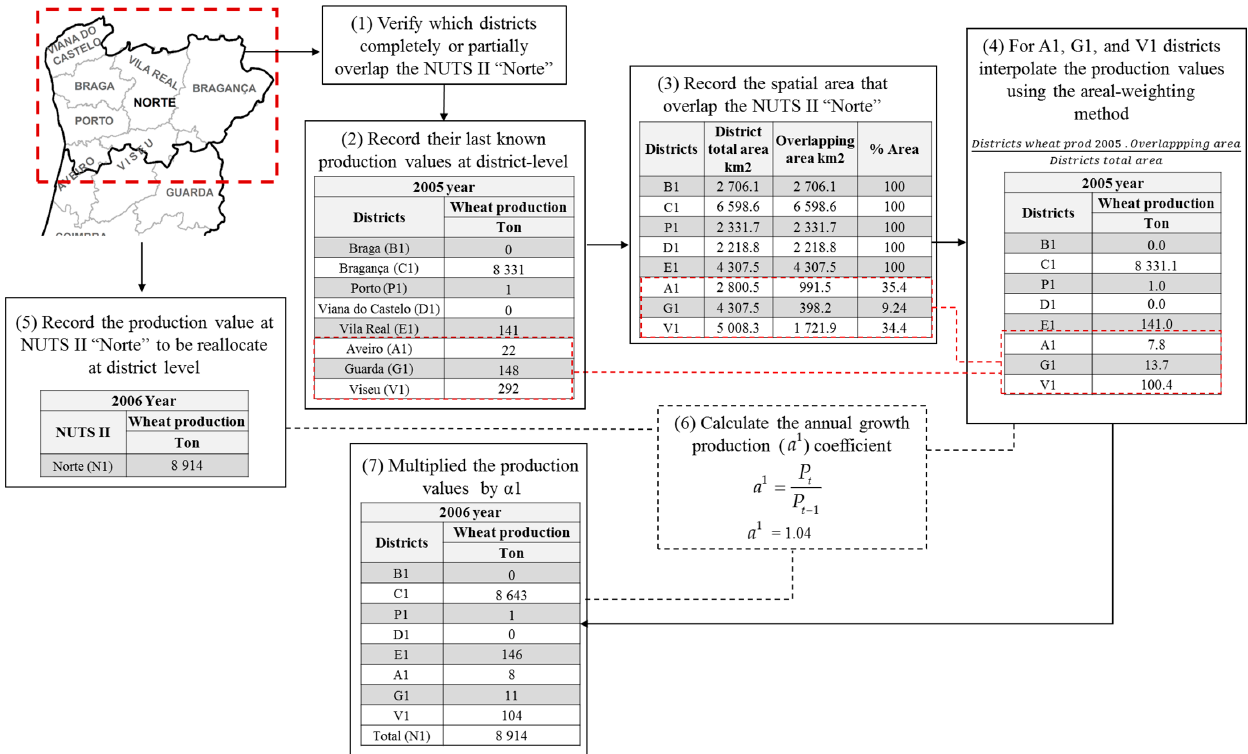
Figure 5. Conceptual diagram of wheat production values interpolation (2006) from NUTS II “Norte” to the district level.